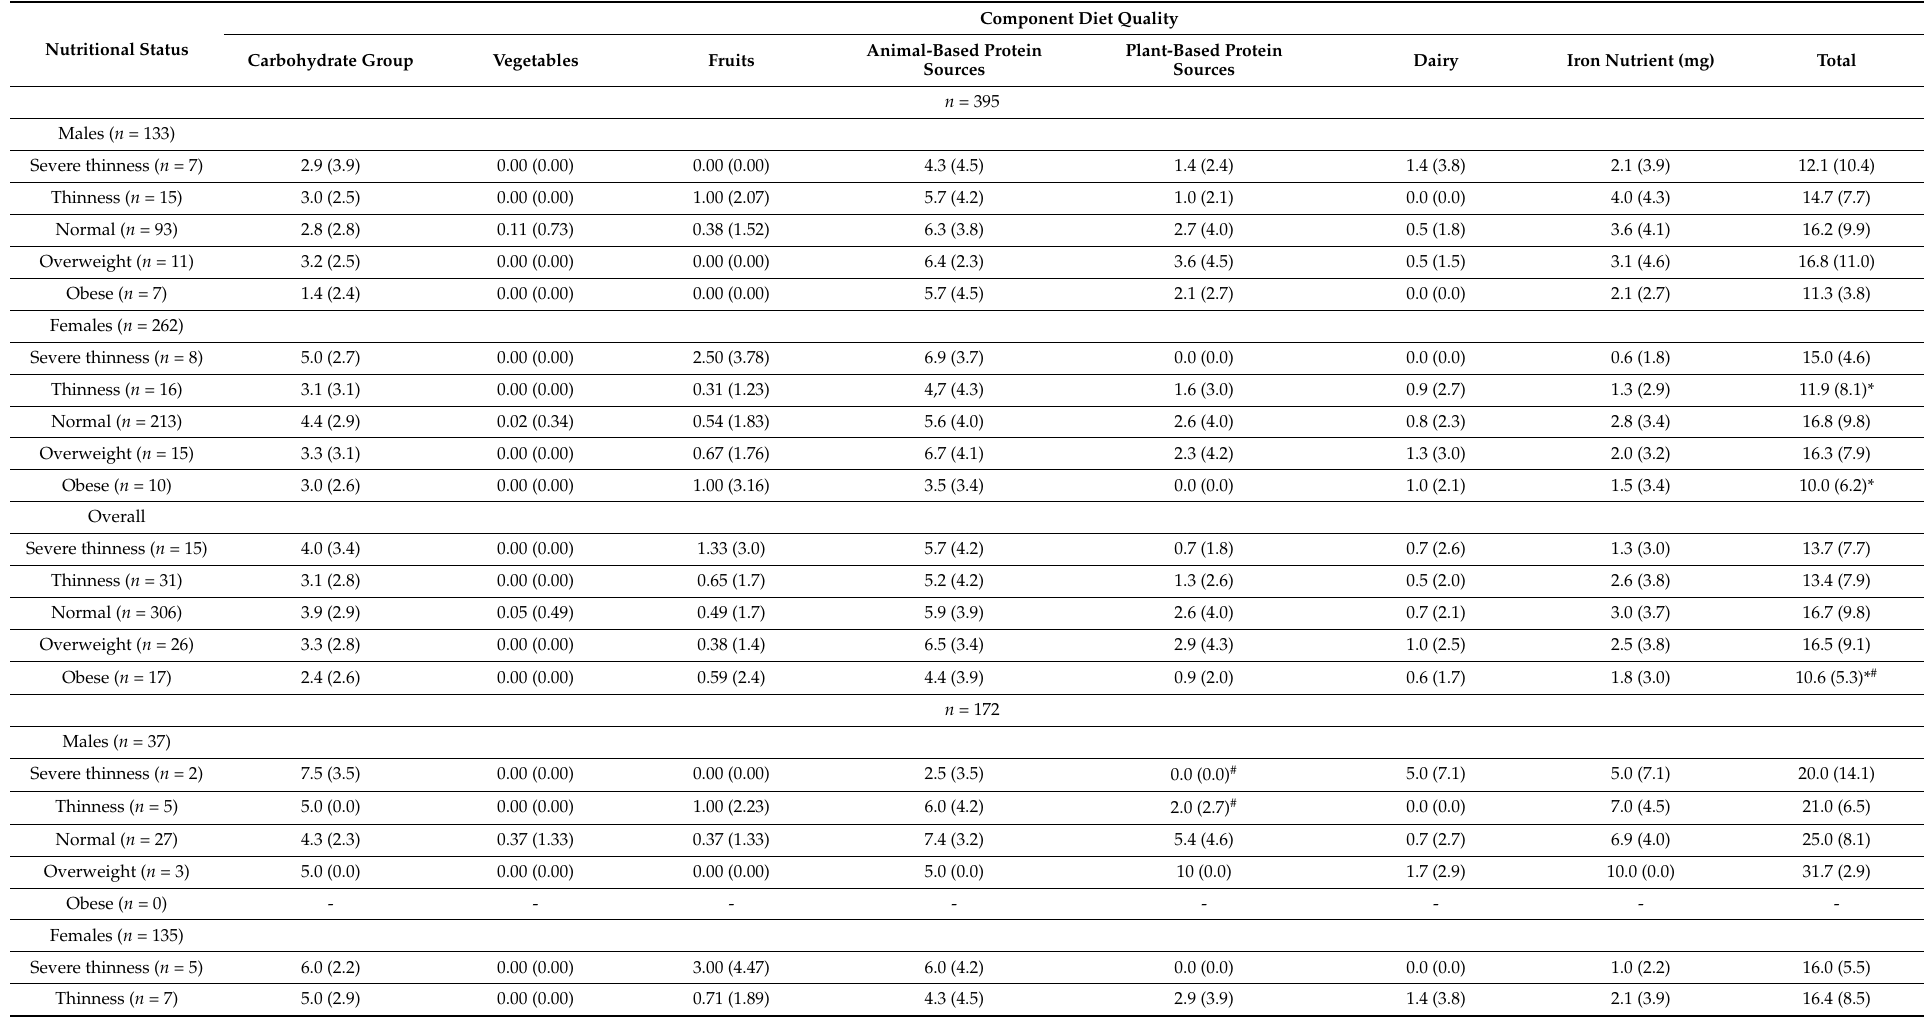
Table 5. Diet quality scores based on the nutritional status in the